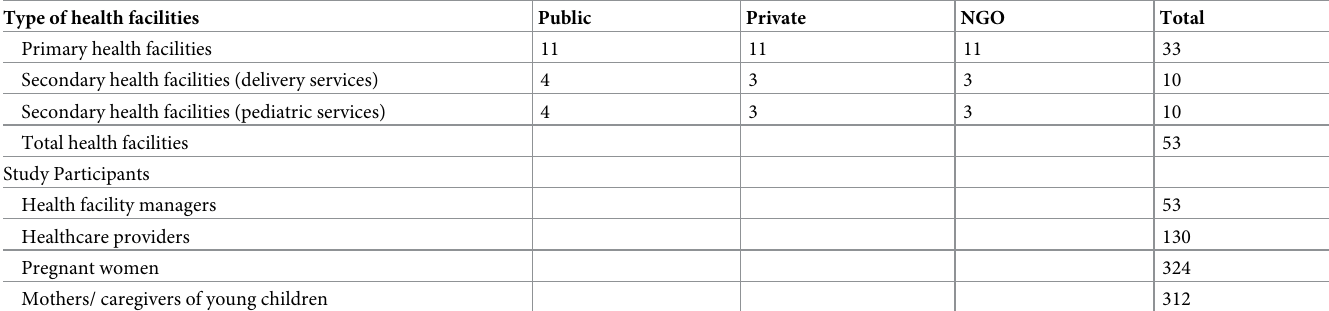
Table 1. Sample size for health facility and study